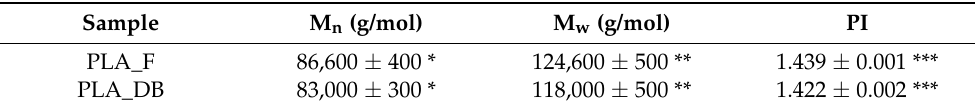
Table 3. Data relevant to SEC analysis.